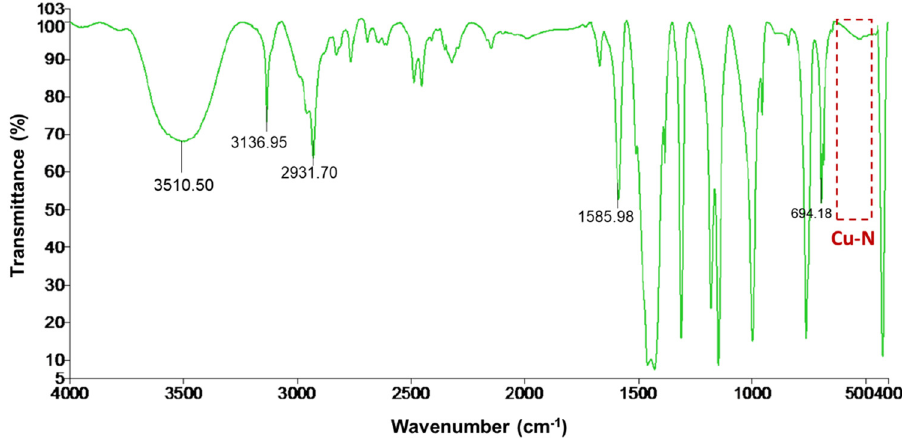
Figure A8: FT - IR pattern of CuZn -